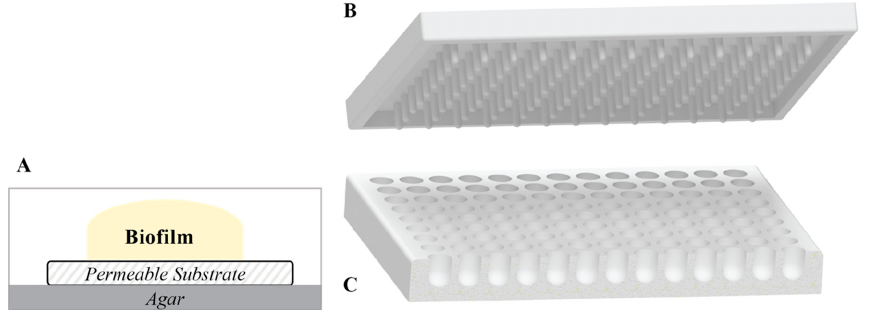
Figure 4. Different systems for static growth of biofilm. ( A ) Colony biofilm model, ( B ) Calgary device lid, and ( C ) round bottom 96-well plate.